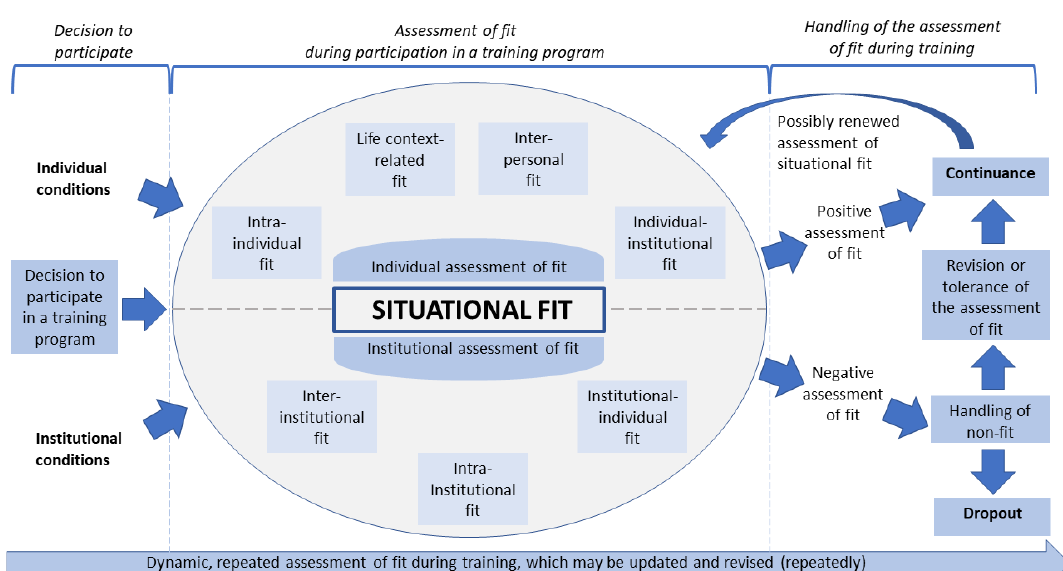
Figure 2 : Integrative model for the genesis of dropout in adult